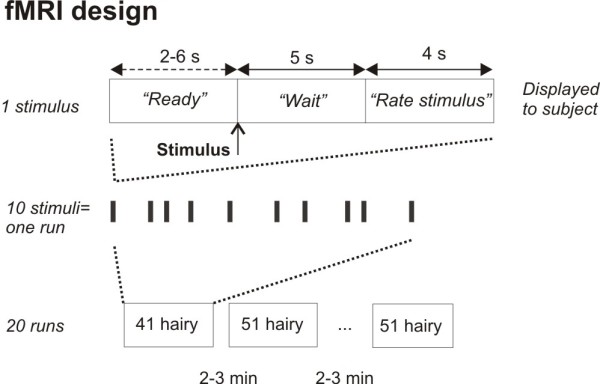
Experimental protocol of fMRI experiment. The top row show the messages displayed to the subject in the scanner for each somatosensory stimulus. The stimulus was delivered after a 2-6 s delay ("Ready" message), followed by a 5 s "Wait" message before a 4 s "Rate stimulus" message was displayed, at which time the subject rated the stimulus on a five-button claw. The middle row illustrates how one stimulus (bars) is repeated 10 times, creating one run. The bottom row illustrates how each run is repeated with different stimulus modalities, making a total of 20 runs. Only stimulus intensities delivered to hairy skin (41°C and 51°C) is reported here. Intermingled were two heat stimulus intensities delivered to glabrous skin and one epidermal electrical stimulus. Results from these stimuli are reported elsewhere.